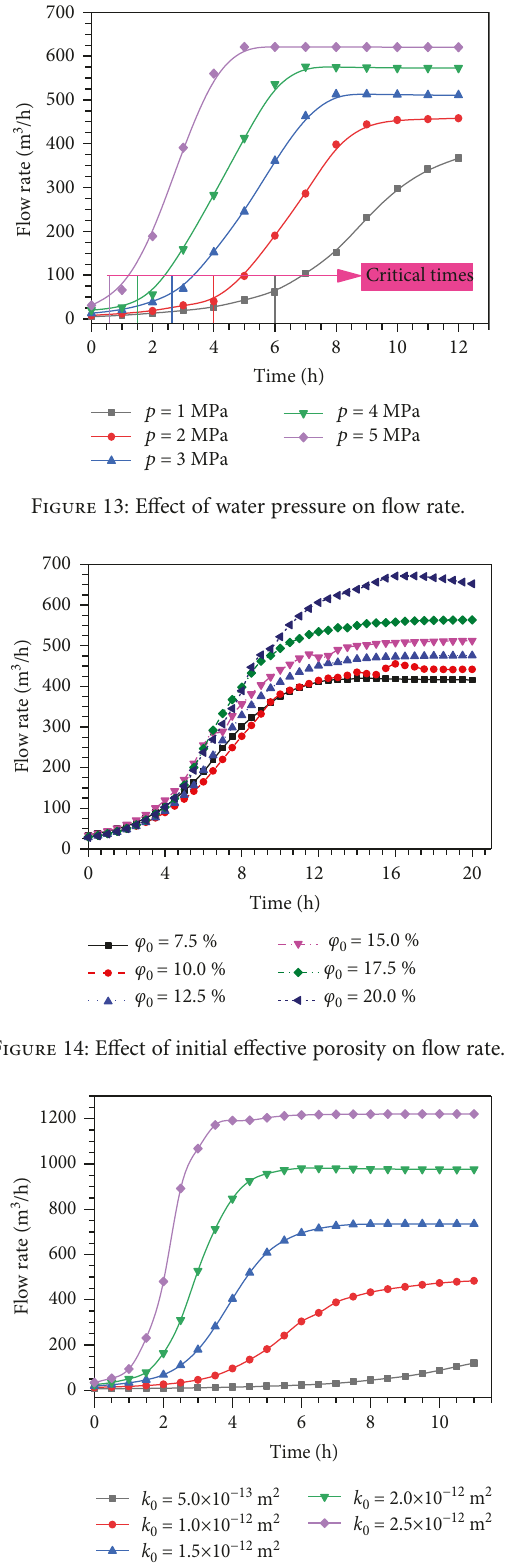
Figure 15: E ff ect of initial permeability on fl ow